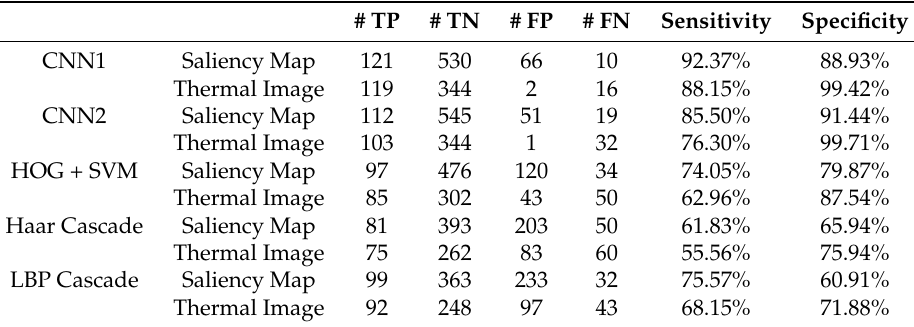
Figure 13. Samples of ROI: ( a ) positive and ( b ) negative samples extracted with saliency map; ( c ) positive and ( d ) negative extracted with thermal image processing. Table 6. Classification performance of all PRS